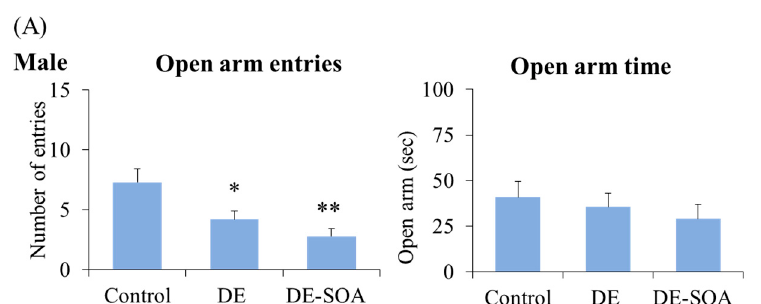
Figure 3. Elevated plus maze test. Number of entries to the open arm and time spent in the open arm in 10-week-old ( A ) male and ( B ) female rats of the control and the DE- or DE-SOA-exposed groups ( n = 10, ** p < 0.01, * p < 0.05 vs. corresponding